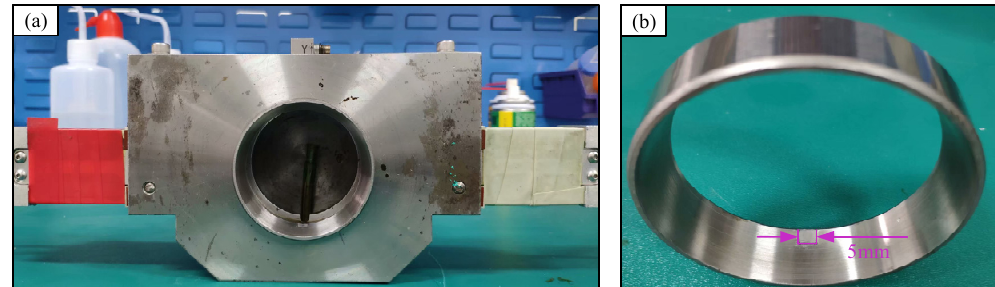
Figure 9. ( a ) Bearing seat; ( b ) TRB outer ring with fault size 5 mm.